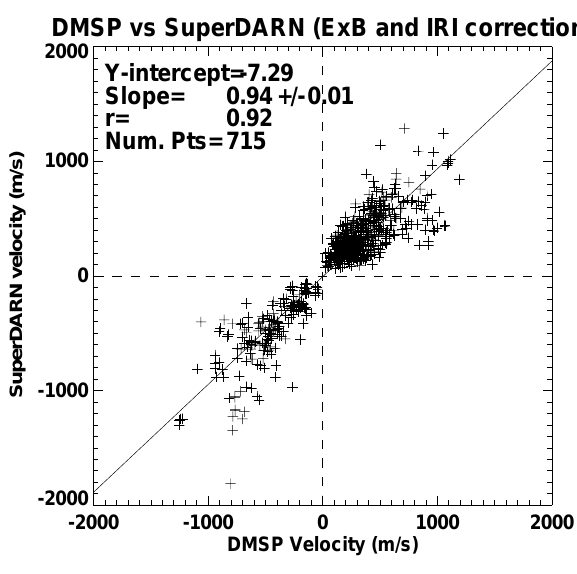
Fig. 15. Same as in Fig. 13 but corrected for both E/B 0 ratio change with altitude and non-unity of refractive